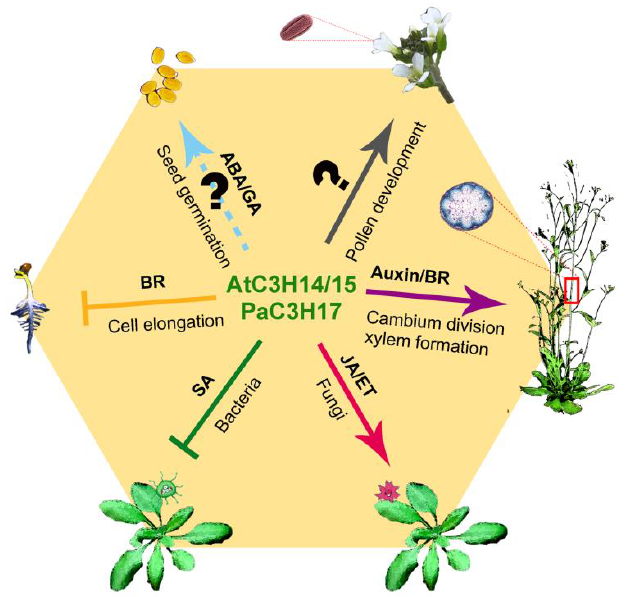
Figure 2. The functions of Arabidopsis AtC3H14, 15 and their poplar ortholog PaC3H17. These CCCH proteins regulate cell elongation in hypocotyls and stems, pollen development, xylem formation and basal defense against bacteria and fungi through the integration of multiple hormones, including BR, auxin, SA and JA/ET. The positive and negative regulations are represented by arrows and T-shaped lines, respectively. A dotted arrow shows unclear hormone regulation.